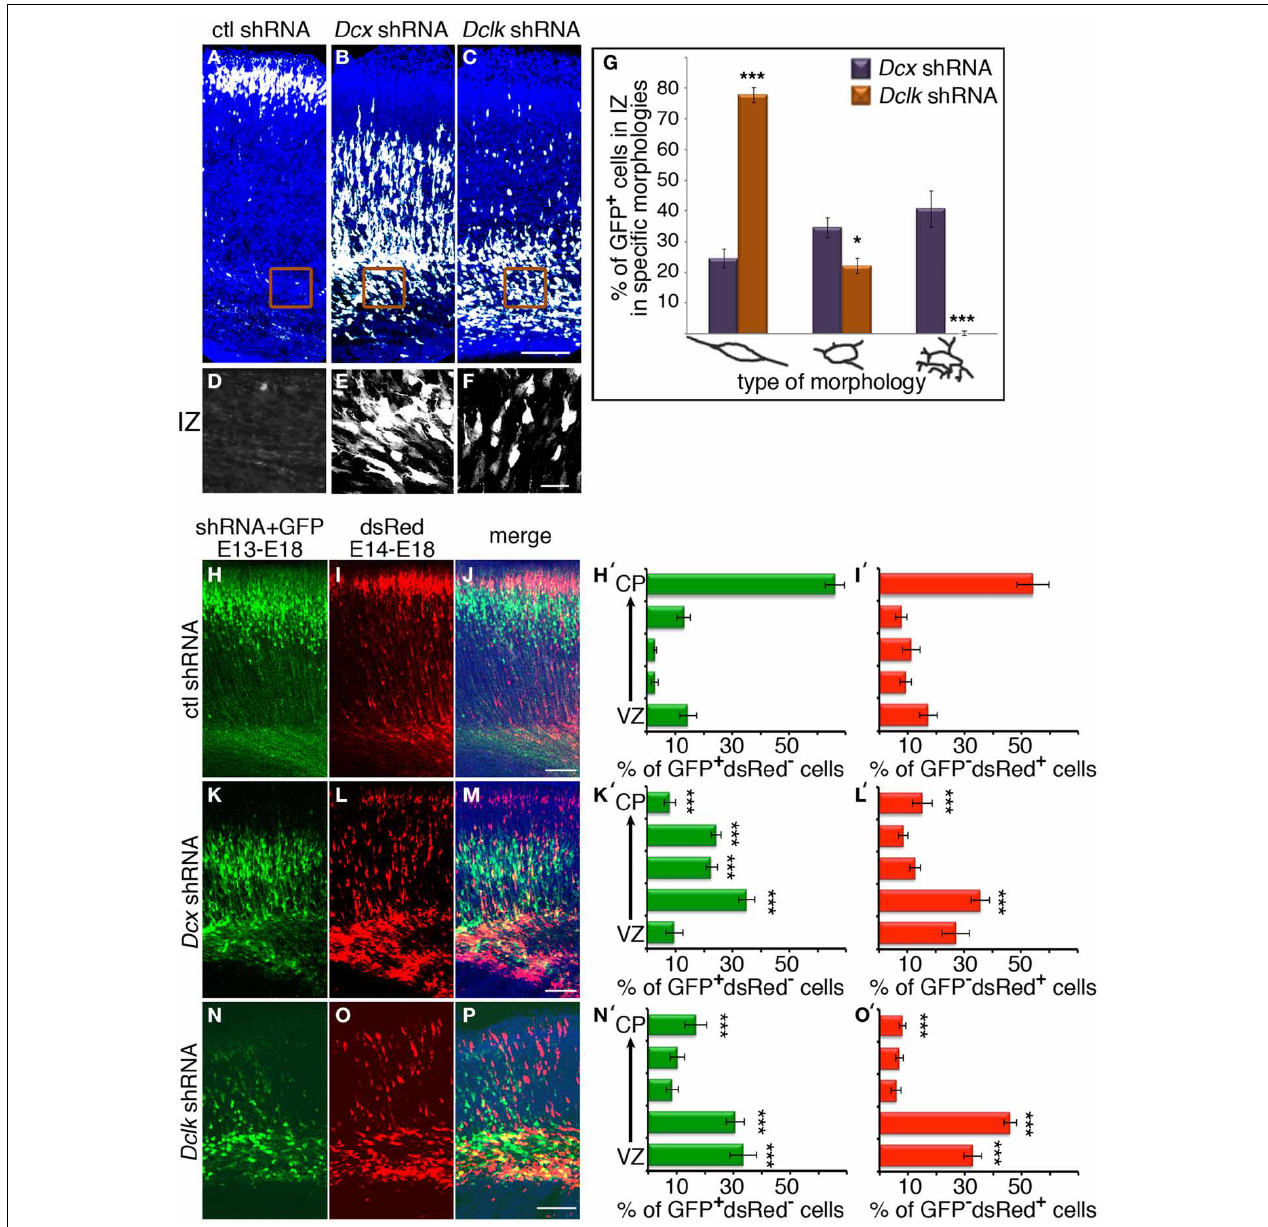
shRNA (K–M) or Dclk shRNA (N–P) together with GFP on E13, followed by electroporation with dsRed on E14. The analysis was performed on E18. GFP-positive cells (H,K,N) , dsRed-positive cells (I,L,O) and merged images (J,M,P) are shown. Only single positive cells were counted and used for quantifications and statistical analysis. In each section the total number of cells were considered 100% and the relative % of green and red cells were calculated in relation to the same population. In the histograms the % of GFP positive dsRed negative or % of GFP negative dsRed positive cells positioned in the different bins are indicated. The statistical analysis is based on number of cell bodies that were counted in five arbitrary bins spanning the width of the cortex. The analysis was done using the Imaris©software (H’,I’,K’,L’,N’,O’) . Scale bar, 100 μ